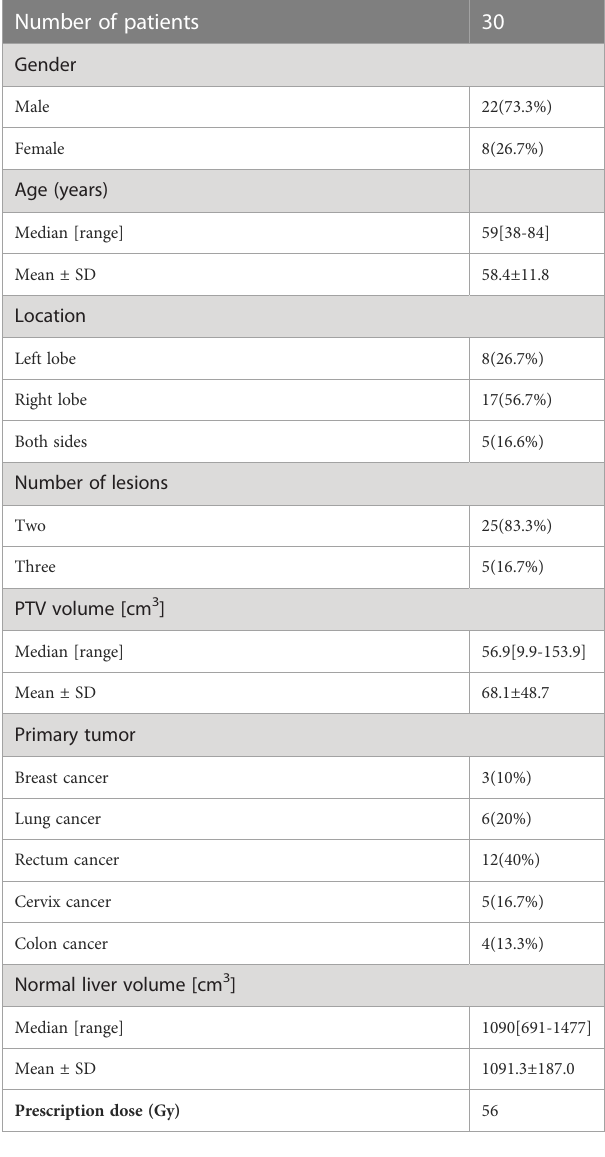
TABLE 1 Characteristics of the 30 patients with MLM enrolled in this